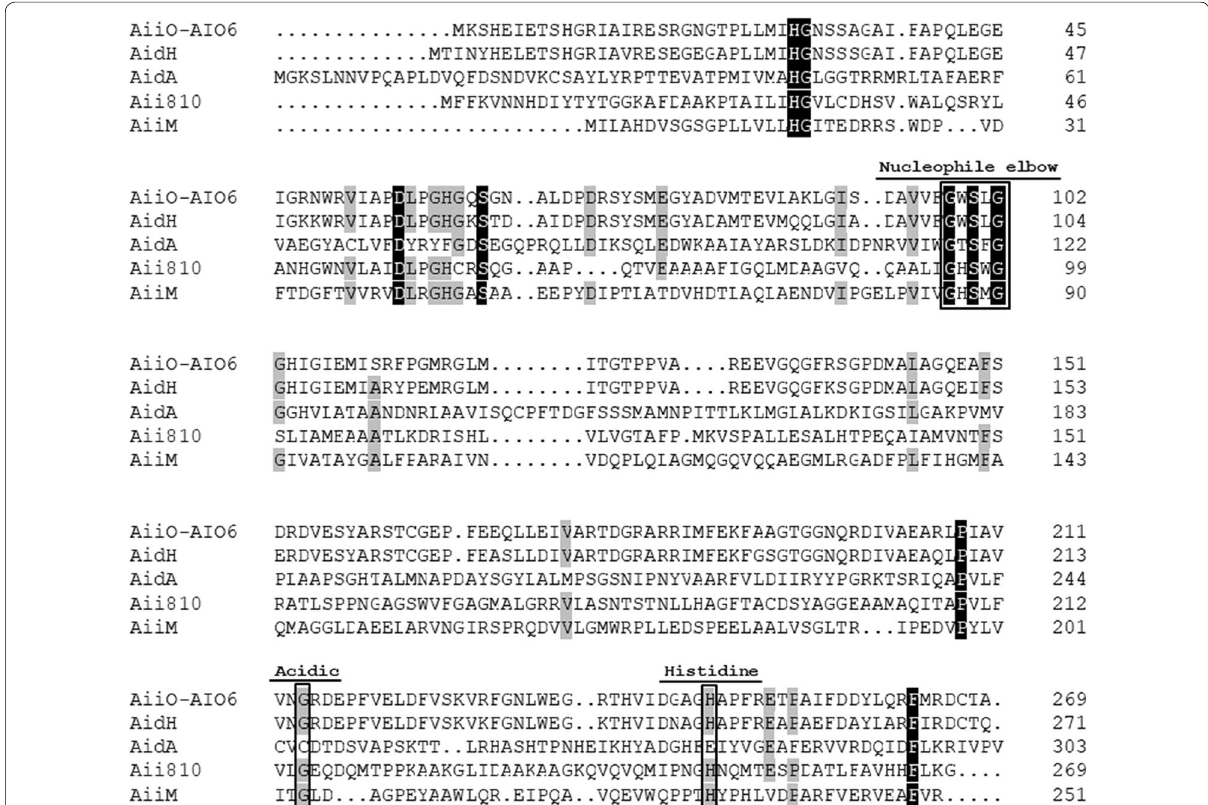
Fig. 7 Comparison of amino acid sequences of AiiO‑AIO6 and several alpha/beta‑hydrolases. The alignment was generated by DNAMAN. Identities are highlighted in white with a black background, and similarities are shaded gray. The catalytic triad residues are boxed with rectangles. The amino acid residues essential for AHL‑degrading activity are indicated by asterisks. AiiO‑AIO6, AiiO‑AIO6 from Ochrobactrum sp. M231 (GenBank accession no. AEX07427); AidH, AidH from Ochrobactrum sp. T63 (GenBank accession no. GQ849010); AidA, AidA from Acinetobacter baumannii (GenBank accession no. ODA53988); Aii810, Aii810 from uncultured bacterium (GenBank accession no. ASY06633.1); AiiM, AiiM from Microbacterium testaceum StLB037 (GenBank accession no.